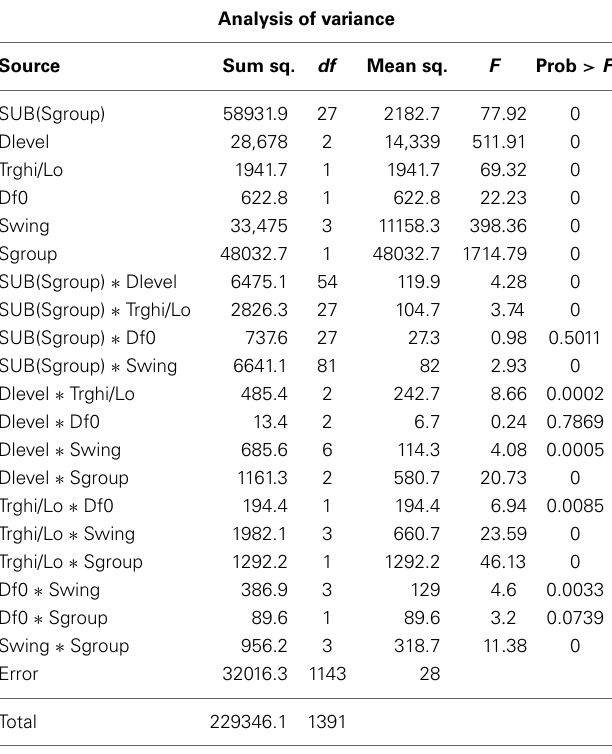
Table 1 | ANOVA of target identification data. the young (blue lines and symbols) subject groups, as a func- tion of the extent of the target formant’s excursion across the Analysis of variance three distracter levels. All panels compare results of the wide ( (cid:2) f0/f0 = 0.77, approximately minor seventh, solid lines) and narrow ( (cid:2) f0/f0 = 0.27, approximately major third, dashed lines) f0 separations. In the top panels the target’s f0 is lower and in the bottom panels it is higher than that of the